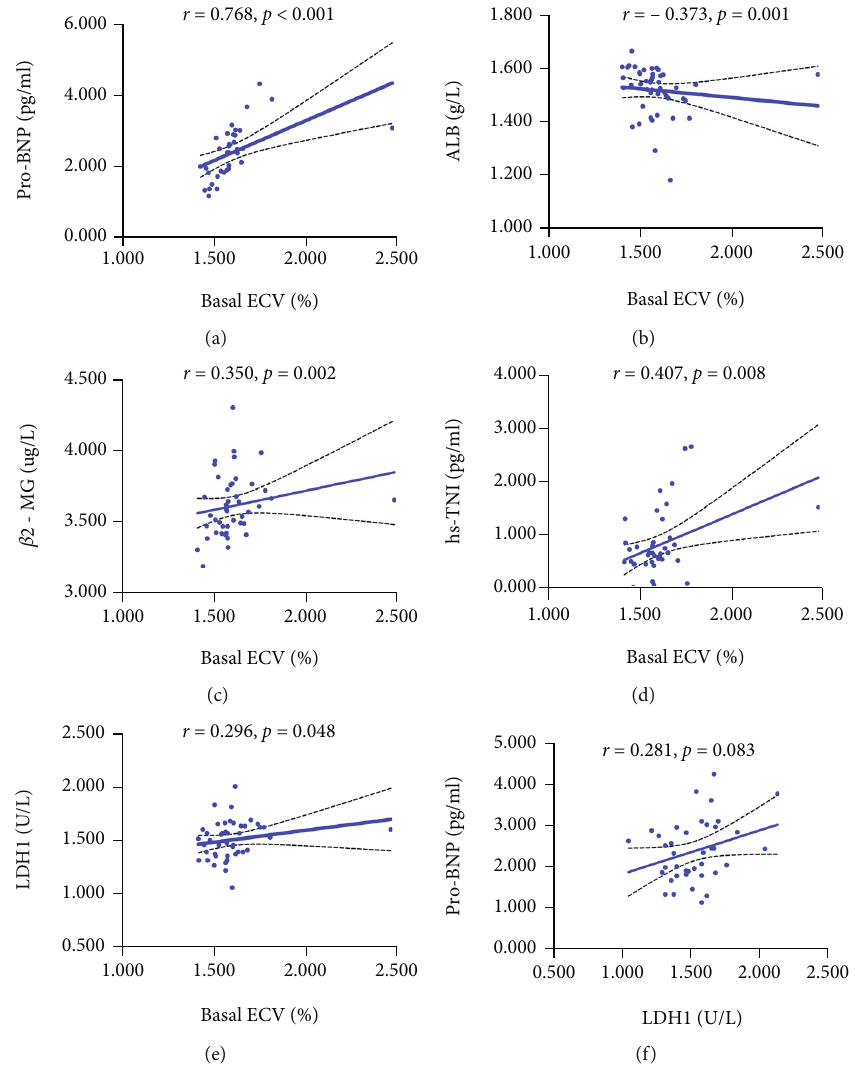
Figure 4: The correlation between basal ECV and other laboratory parameters in 51 MM patients. (a) pro-BNP, (b) ALB, (c) β 2-MG, (d) hs- TNI, and (e) LDH1. The correlated analysis between pro-BNP and LDH1 was shown (f). Spearman ’ s correlation analysis and equation of residuals plots were shown. Table 3: Multivariate logistic analysis of heart